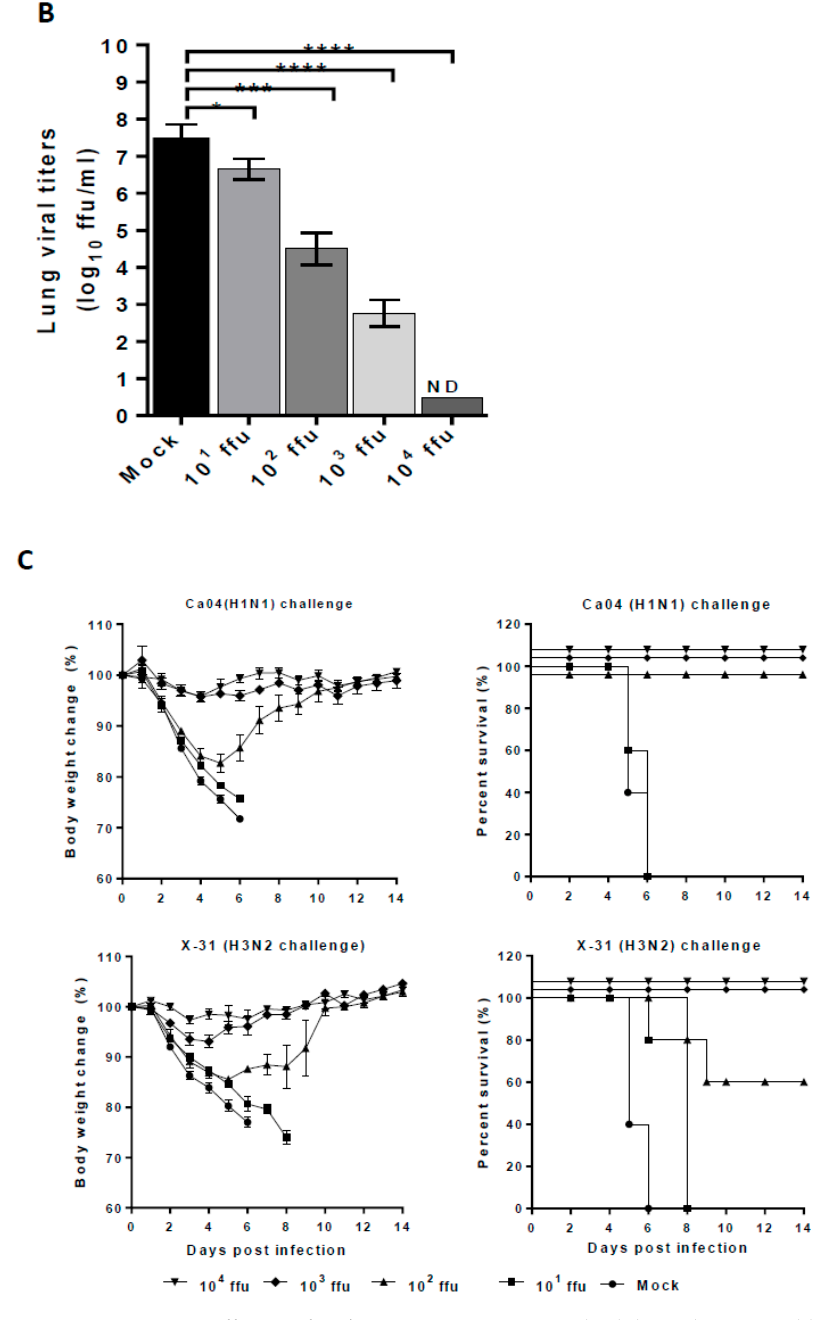
Figure 6. Protective efficacy of 20/13repNA virus against both homologous and heterologous virus challenges. Groups of mice were intranasally vaccinated with different doses of the 20/13repNA virus (10~10 4 ffu) and then challenged 4 weeks post-vaccination. Body weight change of mice ( n = 6). ( A ) Virus titers in the lungs of mice ( n = 3) challenged with 10 LD 50 of wild-type PR8 virus at 3 days post-challenge. ( B ) Error bars denote SD. ND, not detected (detection limit, 10 pfu/mL/lung). ( C ) Body weight change and survival rate of mice challenged with 10 LD 50 of Ca04 (H1N1) (upper panel) or X-31 (H3N2) (lower panel). Error bars denote SEM. * p < 0.05, *** p < 0.001, **** p < 0.0001 (unpaired two-tailed Student’s t